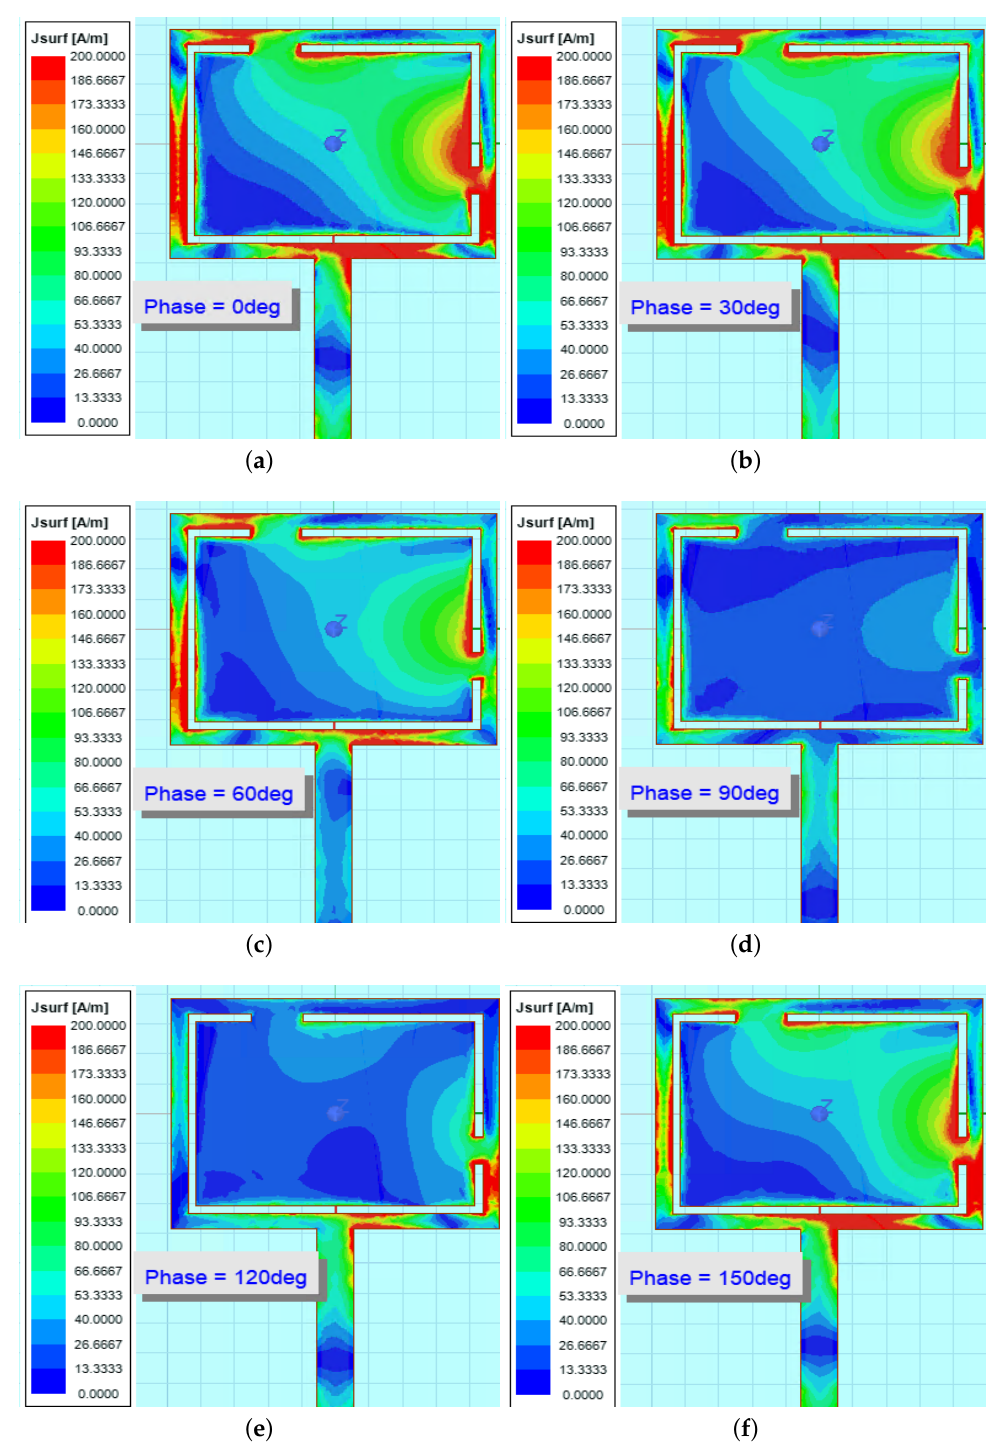
Figure 17. Surface current distribution at 6.2 GHz for cylinder radius of 50 mm. ( a ) 0 degrees; ( b ) 30 degrees; ( c ) 60 degrees; ( d ) 90 degrees; ( e ) 120 degrees; and ( f ) 150